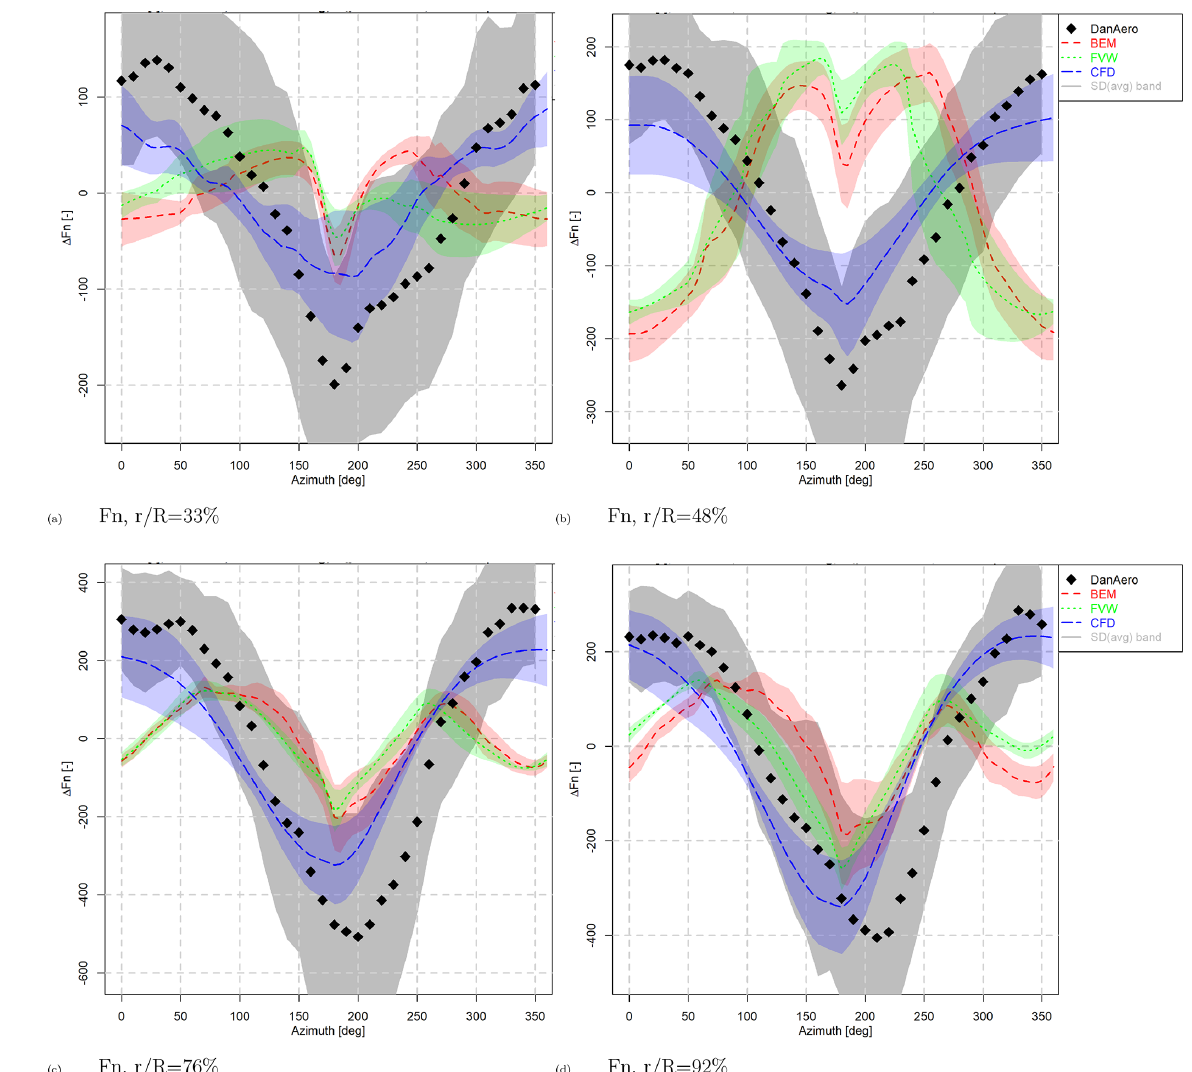
Figure 9. Normal force (Fn) variation by model types, Case